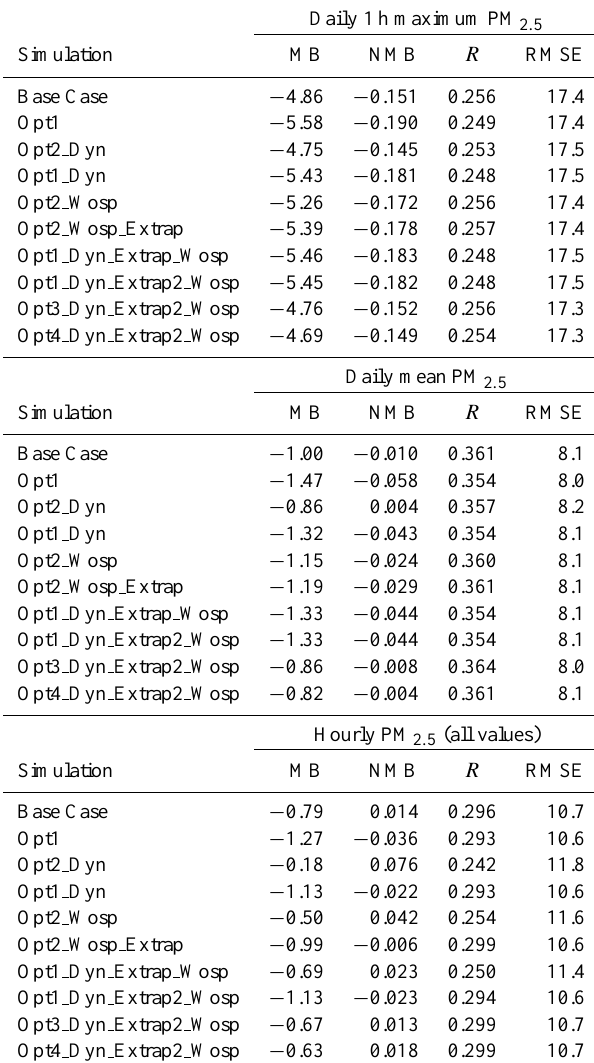
Table 3. Evaluation statistics for 42km grid simulations for PM 2 . 5 .